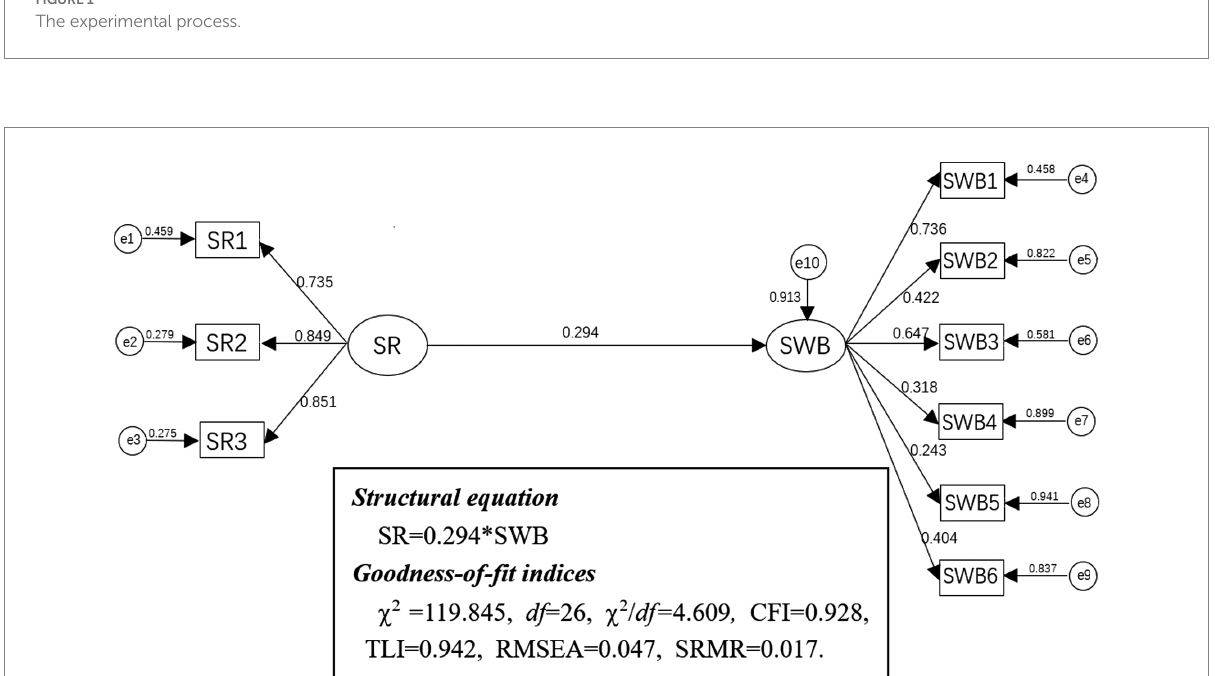
FIGURE 2 Direct effect model. SR, Social responsibility; e1–e3, manifest variables of the package of social responsibility; SWB, Subjective well-being; e4–e9, manifest variables of the six dimensions of subjective